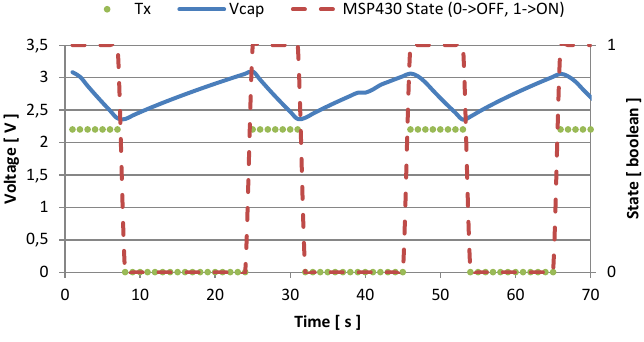
= 1.2 GHz, and CLK